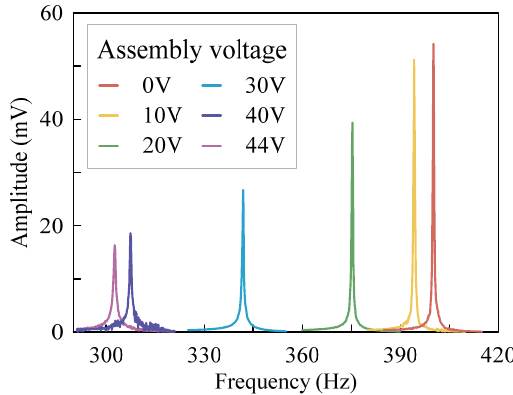
Figure 9. Frequency responses of the accelerometer.